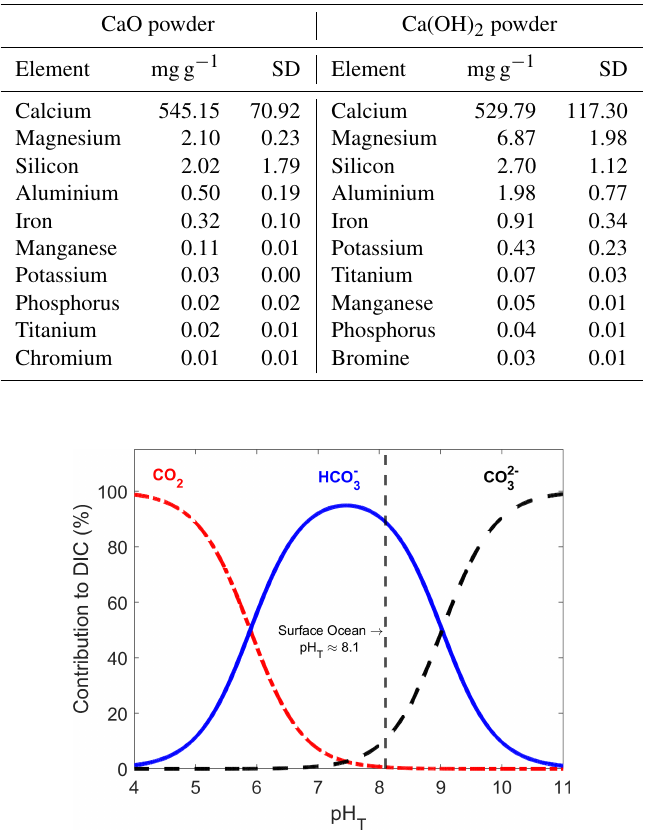
Table A2. Main chemical composition of the CaO and Ca(OH) 2 feedstocks used for the TA increase experiments determined by ICP-MS analysis (expressed in mgg − 1 , with the corresponding standard deviation, SD).